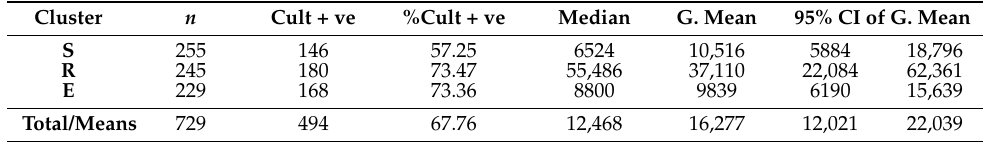
Table interpretation. n = no. of examined samples, Cluster S = soil and water sediments, Cluster R = peat and plant material, Cluster E = faeces and animals’ samples, Cult + ve = culture-positive, G. mean = geometric mean, CI = confidence